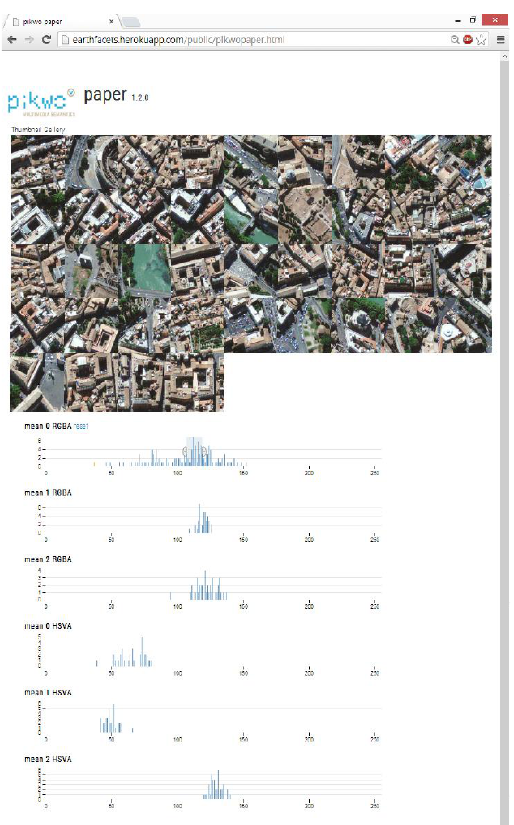
Figure 4: User Interface: a image gallery on top shows a random selection of image tiles. User can interact with the gallery by the bottom half of the interface. This selection panel presents sepa- rated histograms for the complete tile set for each one of the cal- culated features. By clicking and dragging on those histograms the user selects a region of interest in the feature space that can be refined and optimized by moving the limits or the centers of the selections. Each selection operation produces real time update in both the image gallery and in the histograms values displayed. hypercube in feature